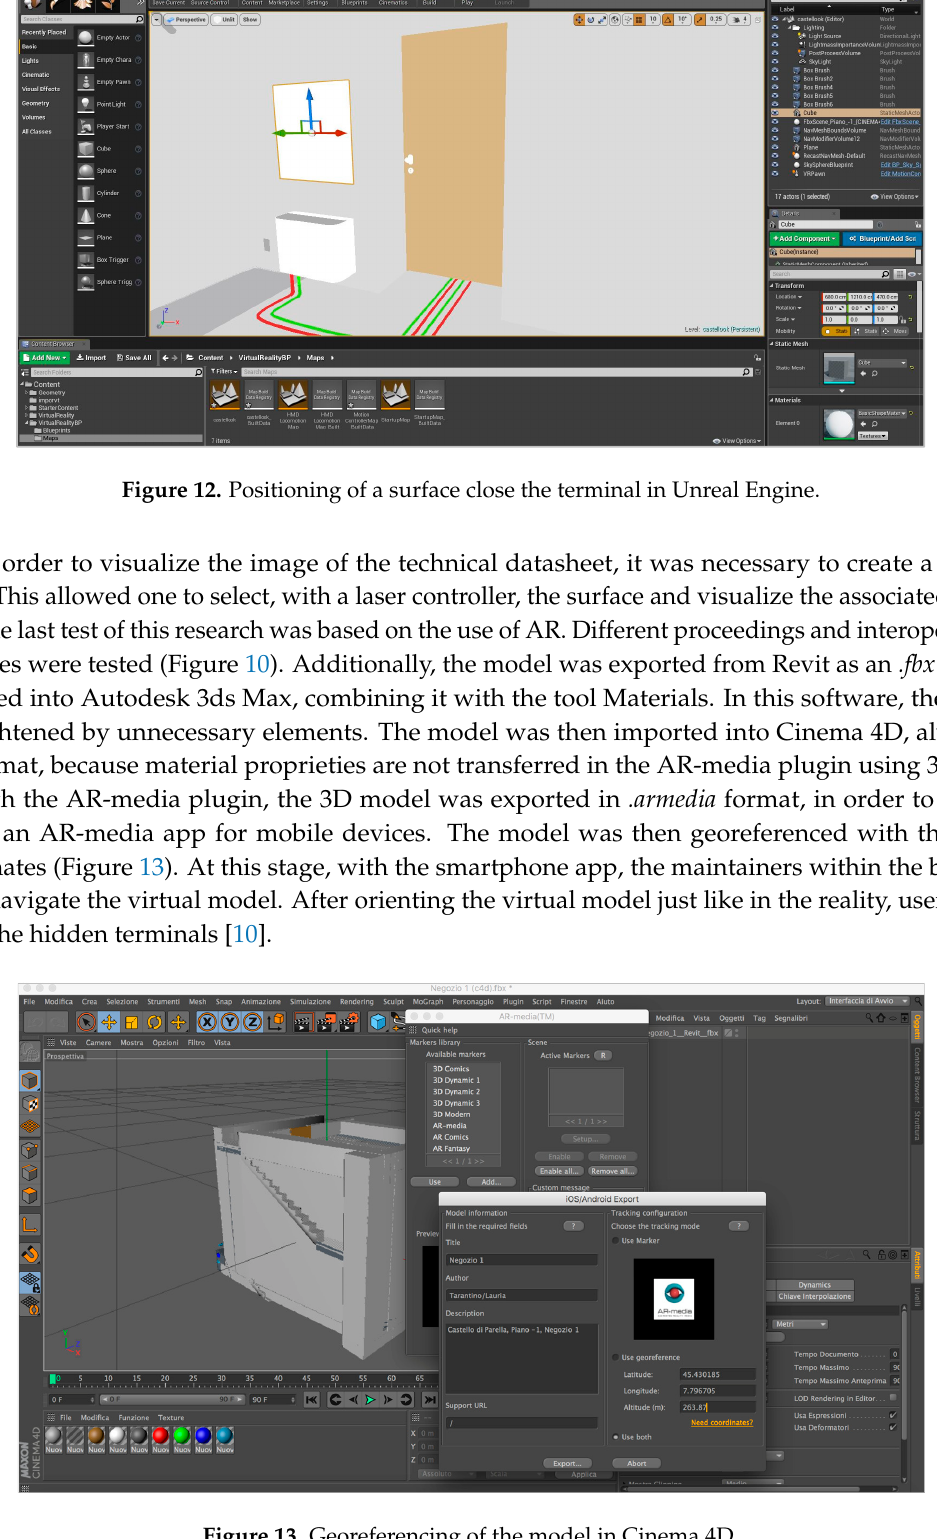
Figure 13. Georeferencing of the model in Cinema 4D.